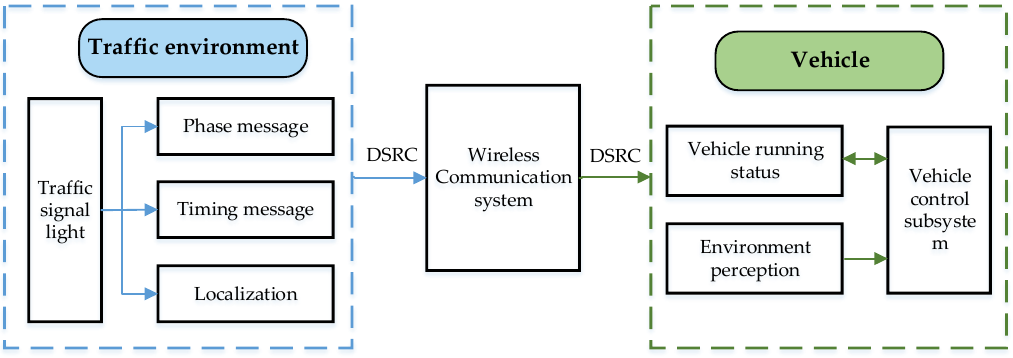
Figure 3. Cooperative vehicle infrastructure system framework.